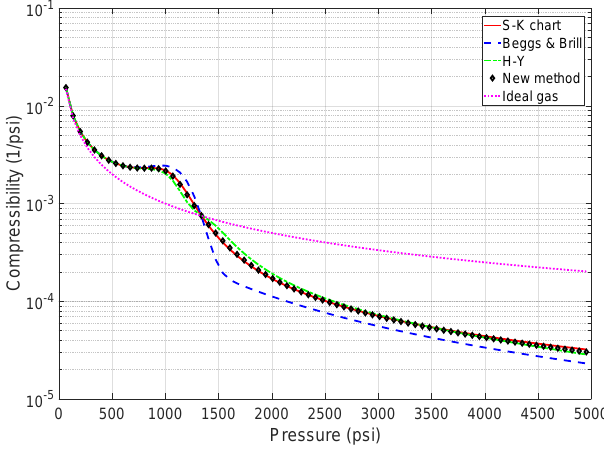
Figure 11. Performance of four methods for the prediction of natural gas